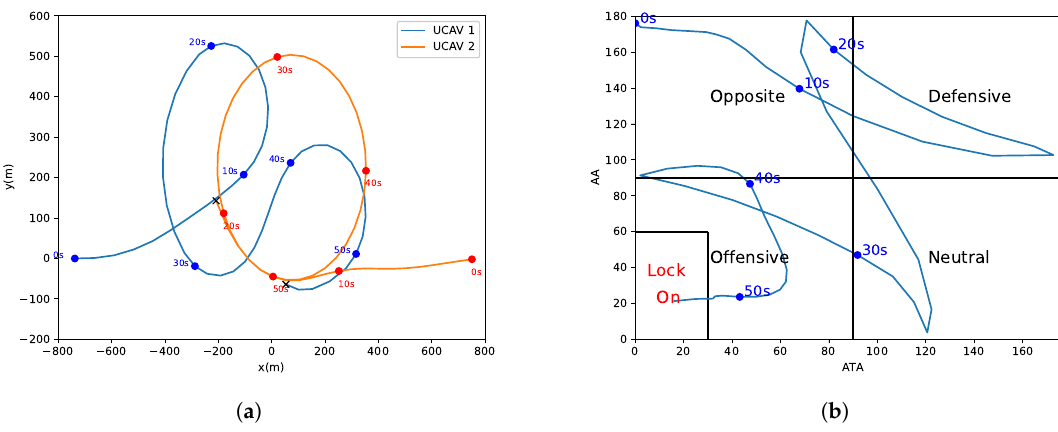
Figure 11. ( a ) Curve of the fly trajectory against RS-MADDPG strategy in the opposite initial situation. ( b ) Curve of the change of air combat situation against RS-MADDPG strategy in the opposite initial situation.